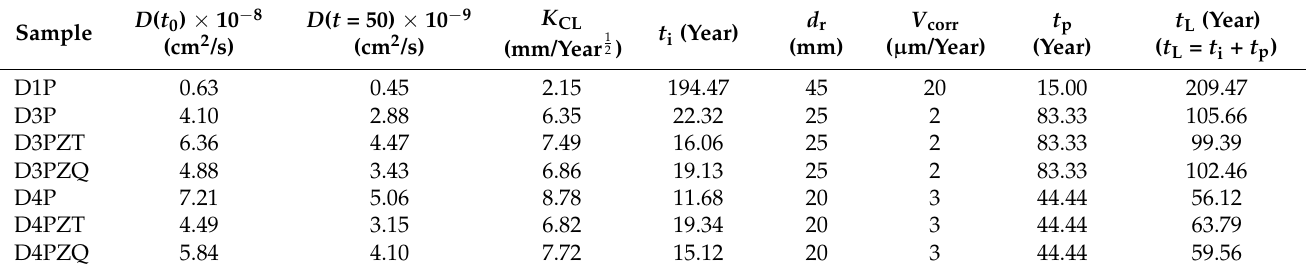
Table 11. Application of the chloride penetration model for the general calculation method of the useful life using data obtained from the pond immersion